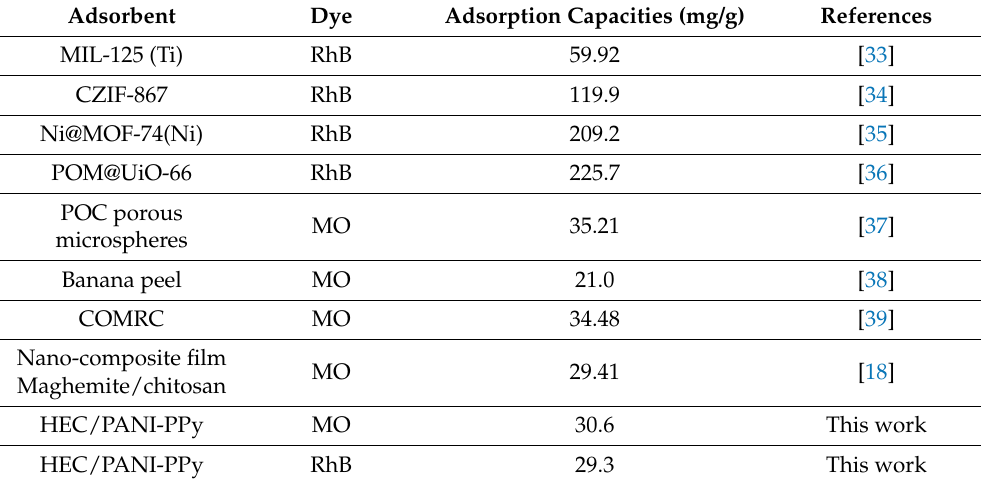
Table 1. Adsorption capacities of some famous adsorbents for MO and RhB.